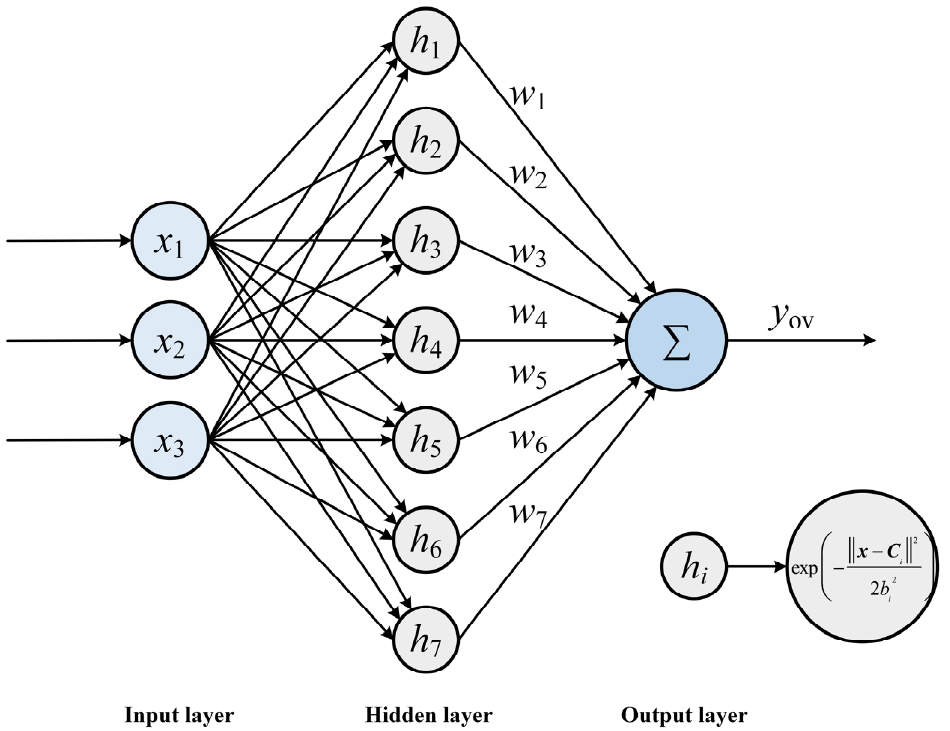
Figure 6. The structure of the RBF network.